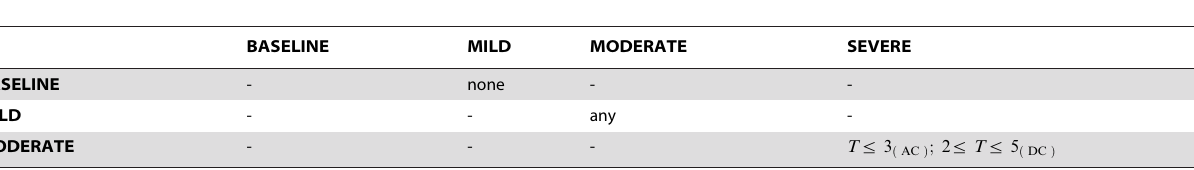
Table 4. Ranges of T in which a significant difference between two phases was found (Wilcoxon signed rank test, p , 0.05).